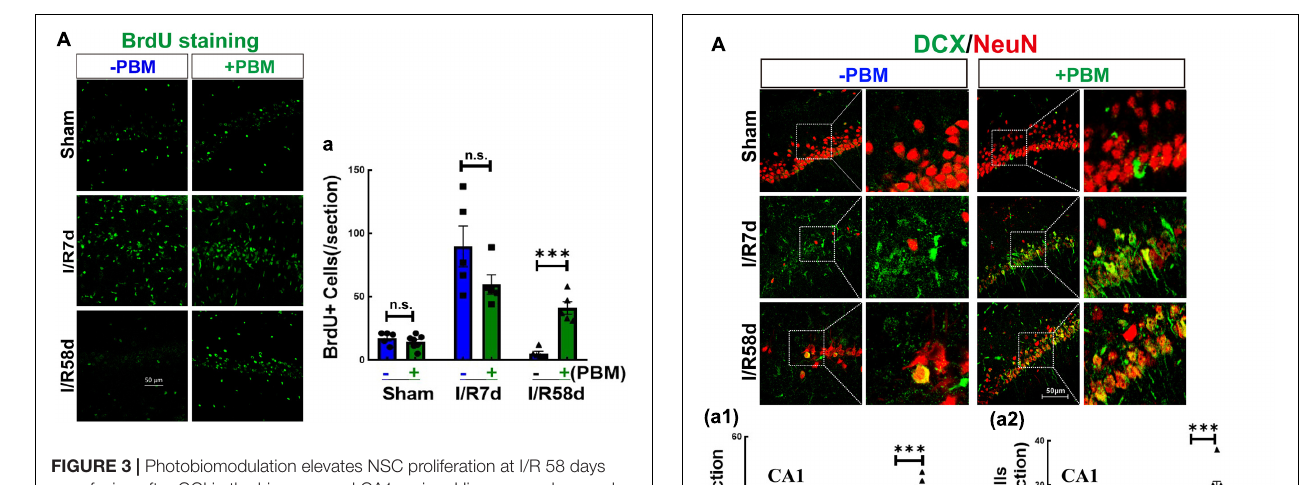
FIGURE 3 | Photobiomodulation elevates NSC proliferation at I/R 58 days reperfusion after GCI in the hippocampal CA1 region. Hippocampal coronal sections from sham and I/R 7 days and I/R 58 days rats treated with or without PBM were used to detect NSC proliferation (BrdU+). (A) Representative images of IF staining for BrdU (green) in the hippocampal CA1 regions and (a) quantification of BrdU+ cells in the sections. n.s., no significant difference ( n = 5–7 in each group). ∗∗∗ P < 0.001 between the two groups. Scale bar: 50 µ m; magnification: 40 × .